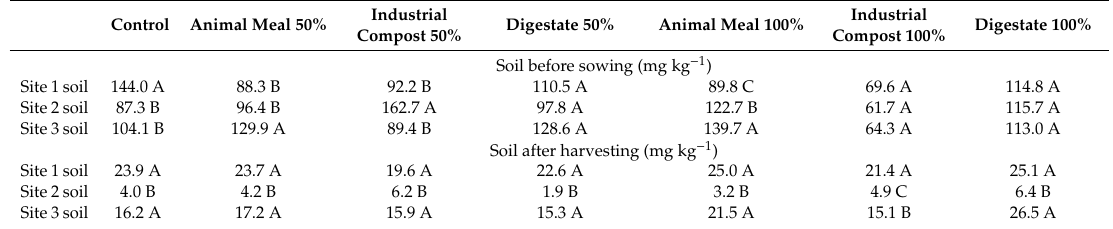
Industrial Digestate 100% Compost 100%